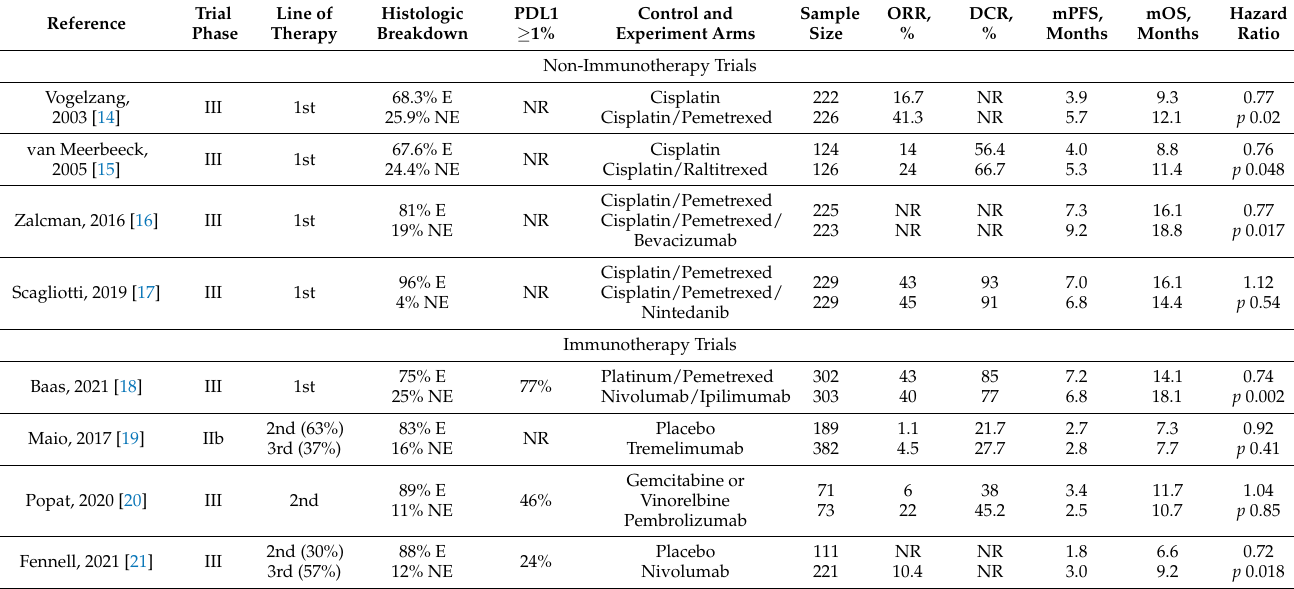
Table 1. Key randomized trials in advanced malignant pleural